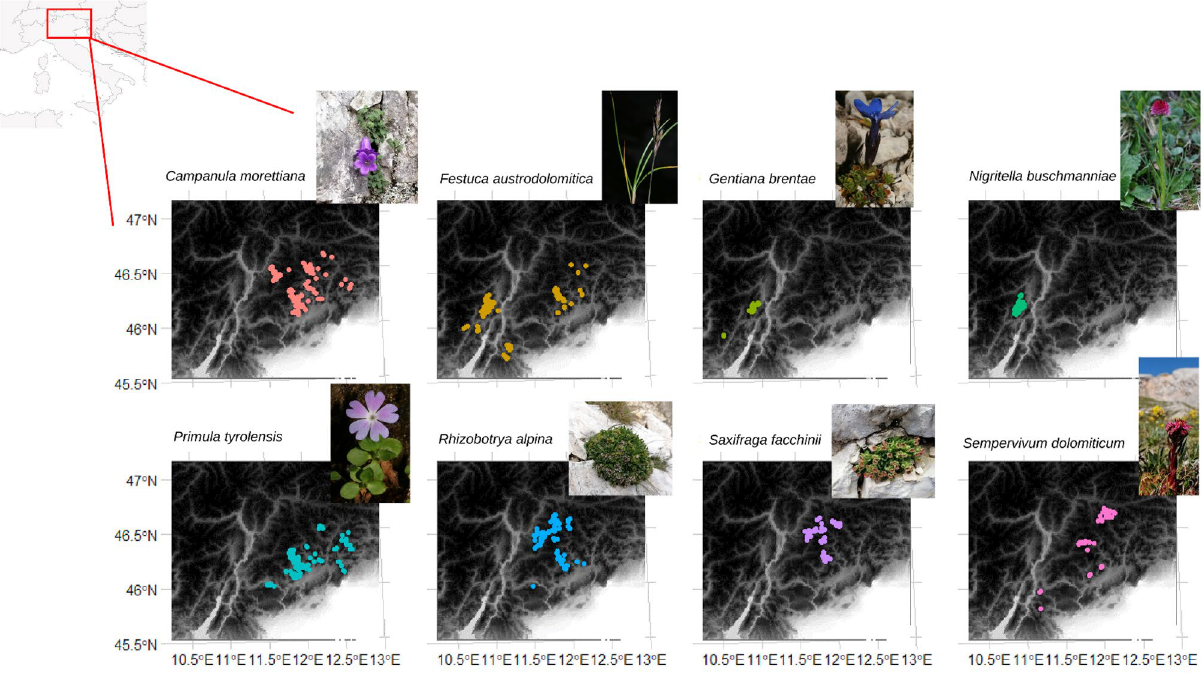
Figure 1. Study area location (Dolomites, south-eastern Alps, Italy) and species occurrences (colored dots) for the eight narrow endemic study species within their distribution range. Photo by Rota F. ( Campanula morettiana Rchb. Rhizobotrya alpina Tausch, Saxifraga facchinii Koch and Sempervivum dolomiticum Facchini), photo by Prosser F. ( Festuca austrodolomitica Pils and Prosser, Gentiana brentae Prosser and Bertolli, Primula tyrolensis Schott ex Rchb., Nigritella buschmanniae Teppner and